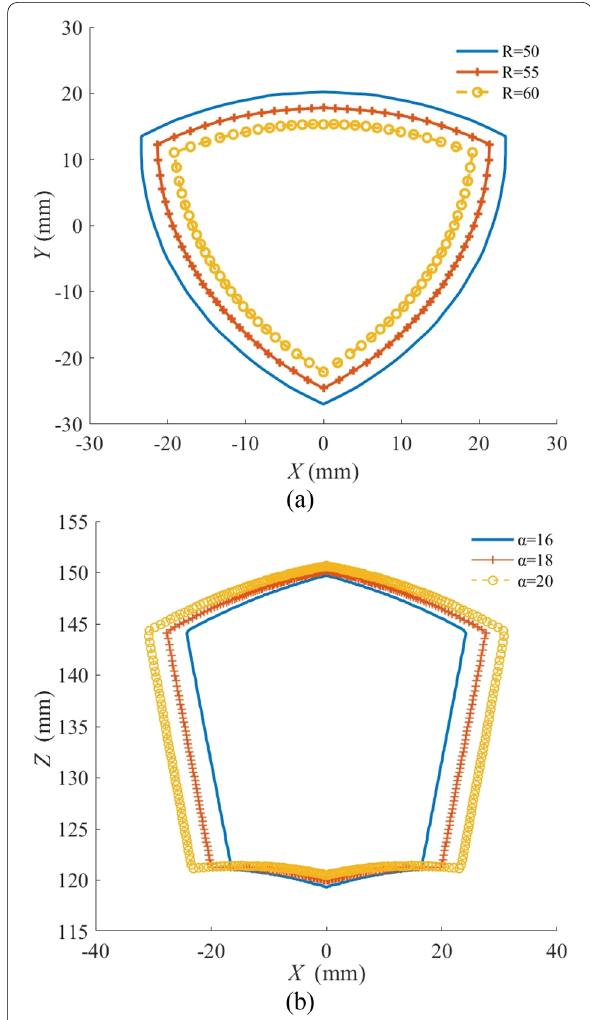
Figure 14 Influence of structural parameters on workspace: R and R o , α and β